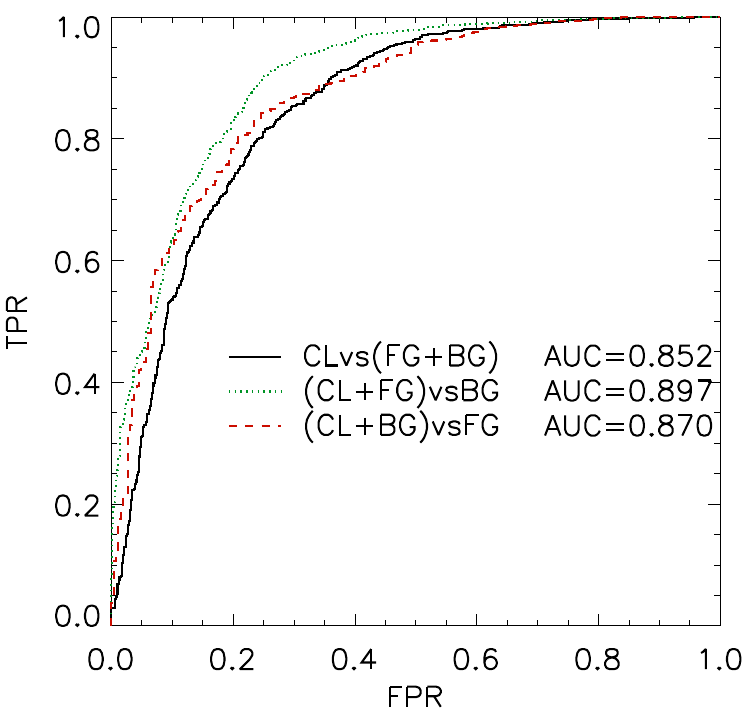
Figure 7. Decoupling of foreground or background galaxies. Separating the background galaxies, labeled as ‘(CL + FG)vsBG’ turns out to be somewhat easier than separating the cluster membership, labeled as ‘CLvs(FG + BG)’, or than separating the foreground galaxies, labeled as ‘(CL +